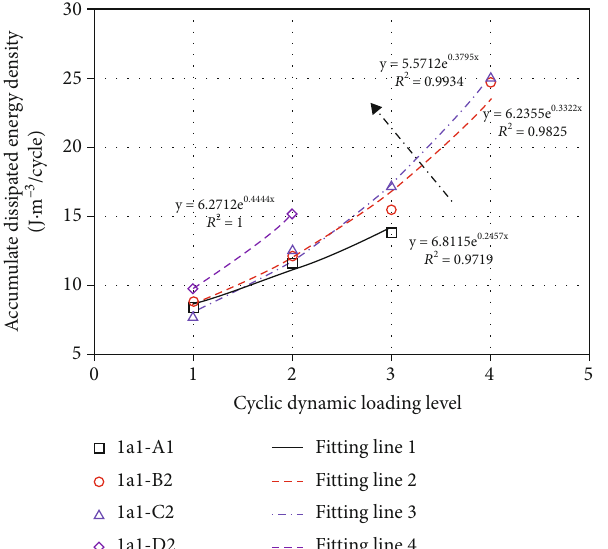
Figure 9: Relation of accumulated energy dissipation density and cyclic dynamic loading level.